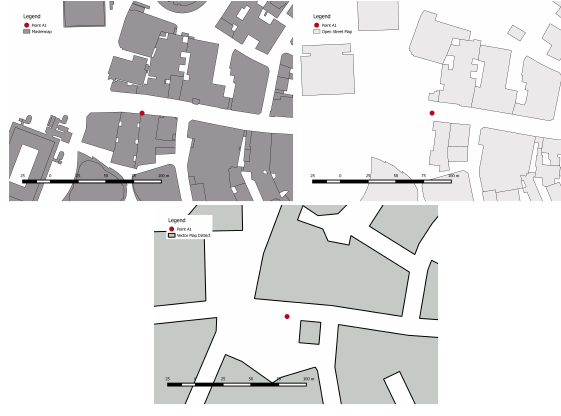
Figure 10: Point A1 on OSMM (top), OSM (middle) and VMD (bottom)